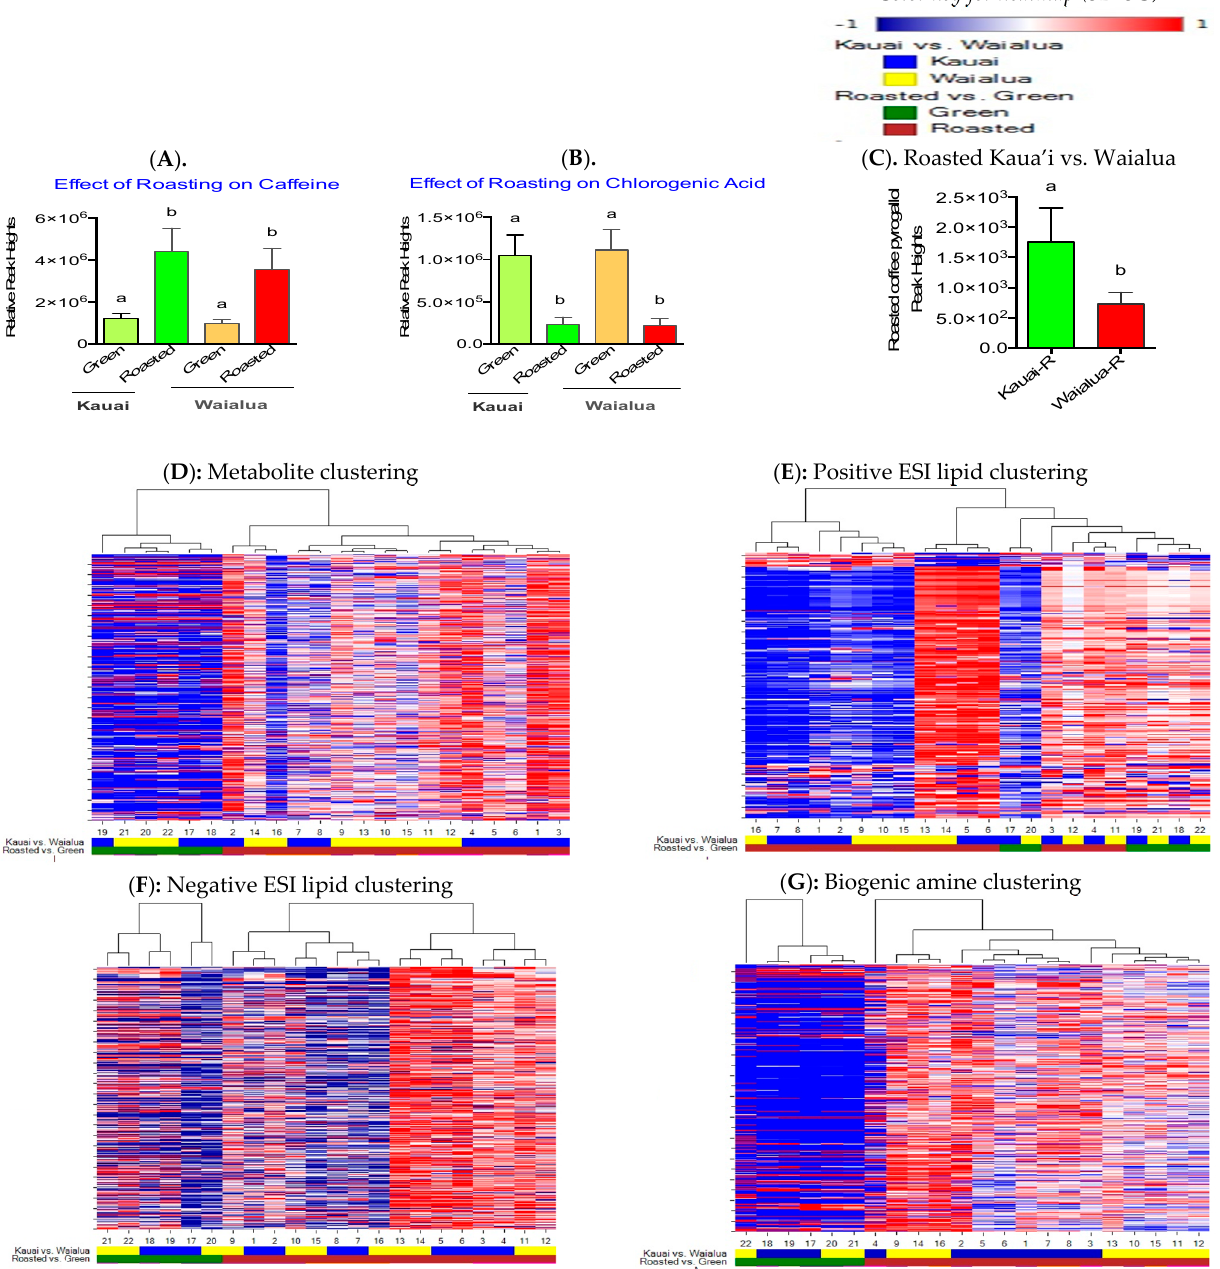
Figure 3. Effect of roasting on caffeine ( A ), chlorogenic acid ( B ), and pyrogallol ( C ), analyzed using GraphPad Prism 7.0. Values are mean ± SD (n = 8). a,b Mean values with common letters do not differ ( p < 0.05). Heatmaps of Kaua’i and Waialua coffee for known global metabolites ( D ), positive ESI mode lipids ( E ), negative ESI mode lipids ( F ), and biogenic amines ( G ). Roasted Kaua’i coffee brews demonstrated significant differences in 102 known and 209 unknown metabolites tentatively assigned as global metabolites, 119 metabolites ten- tatively assigned as positive ESI mode lipids (5 known and 114 unknown), 678 metabolites tentatively assigned as negative ESI mode lipids (8 known and 670 unknown), and 1132 metabolites tentatively assigned as biogenic amines (38 known and 1094 unknown) as compared to the green Kaua’i coffee brews ( p < 0.05, supplement file 3). Figure 4 compares relative changes in selected metabolites, lipids, and biogenic amines of green and roasted Kaua’i coffee brews (adjusted p value (FDR) < 0.05).